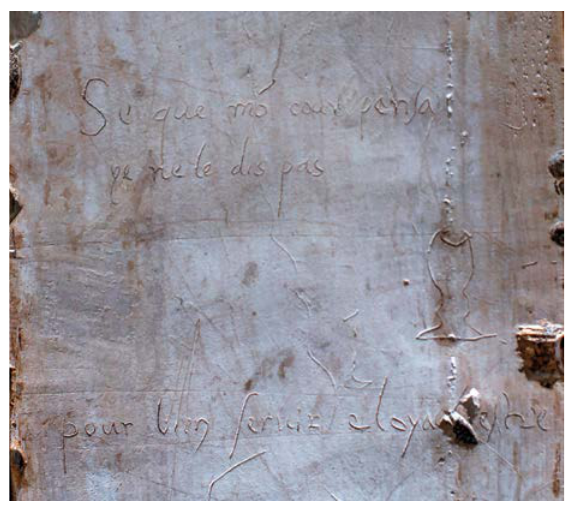
Figure 9 – Graffito ‘Se que mon cour pansa / je ne le dis pas / pour bien servir e loyal estre’. Photo by Manuele